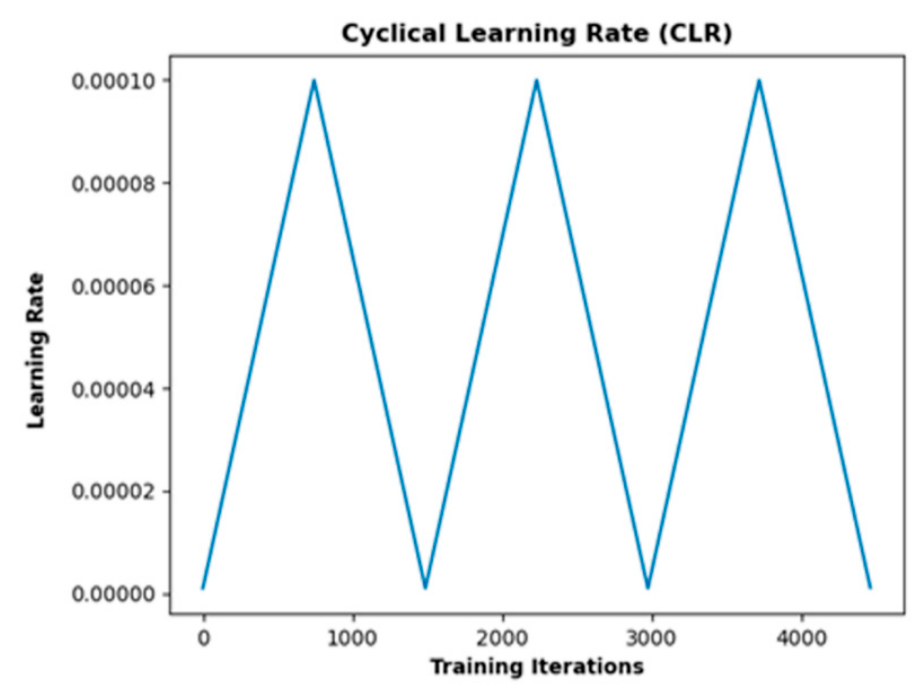
Figure 22. Cyclical learning rate using the triangular method. Table 10. Layers of VGG19.